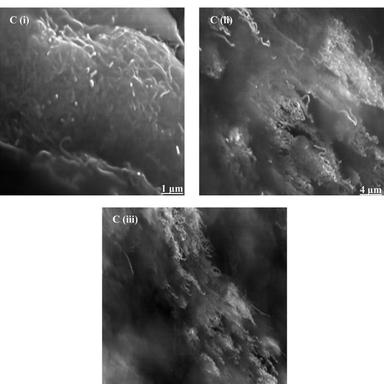
High resolution transmission electron microscope analysis.